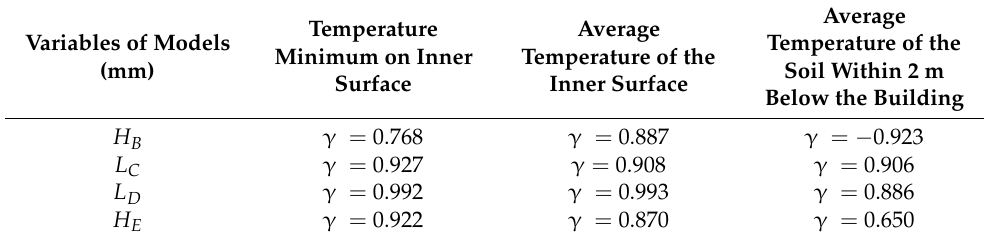
Table 9. Pearson correlation